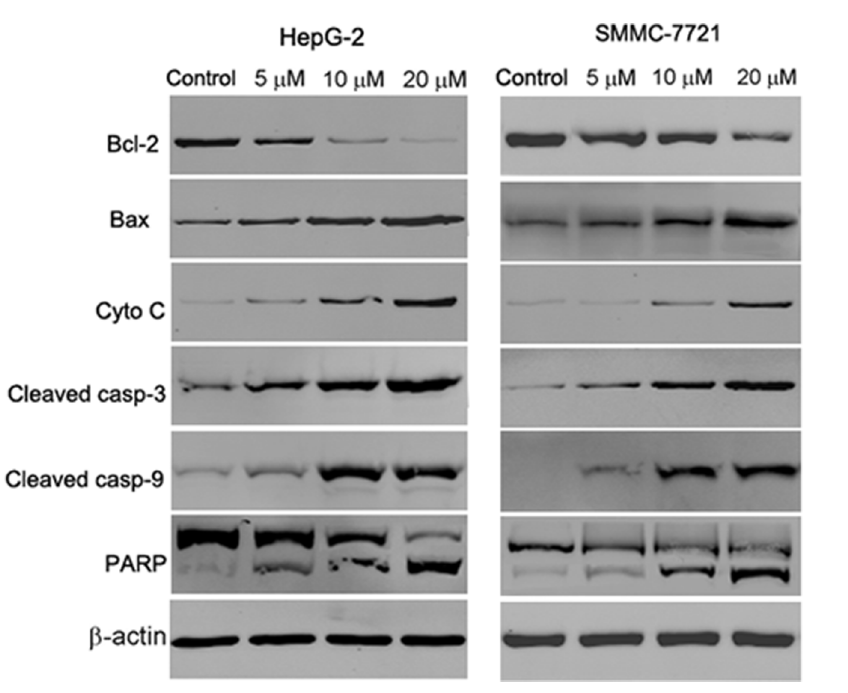
Fig. 6. The effect of abieslactone on the expression of caspase-dependent mitochondrial apoptosis pathway proteins in HepG2 and SMMC7721 cells. Representative images of cytochrome c, Bax, Bcl-2, PARP, cleaved caspase 9 and cleaved caspase 3 protein expression detected by western blot. b -actin was used as a control.